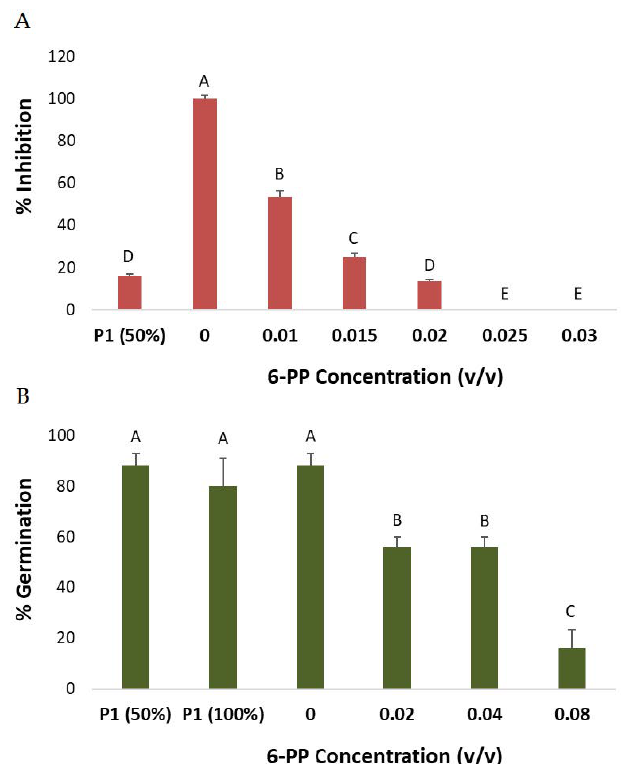
Figure 7. Seeds phytotoxicity assay for the 6-Pentyl- α -pyrone (6-PP). ( A ) T. asperellum (P1)-secreted metabolites (growth medium) or commercial 6-PP compound was embedded in PDA at the indicated dosages and tested for M. maydis inhibition, as described in Figure 2. ( B ) Impact of growth media of P1 or commercial 6-PP compound on corn seed germination. In each Petri dish, five grains were seeded in 3.5 mL of tap water, secretion products (growth medium filtrate after 6 days P1 growth), or commercial 6-PP compound at various concentrations, v / v ). Data are average after three days of incubation. Vertical upper bars represent the standard error. Levels not connected by the same letter (A–C) differ significantly from the other treatments in the same measure ( p < 0.05, ANOVA).